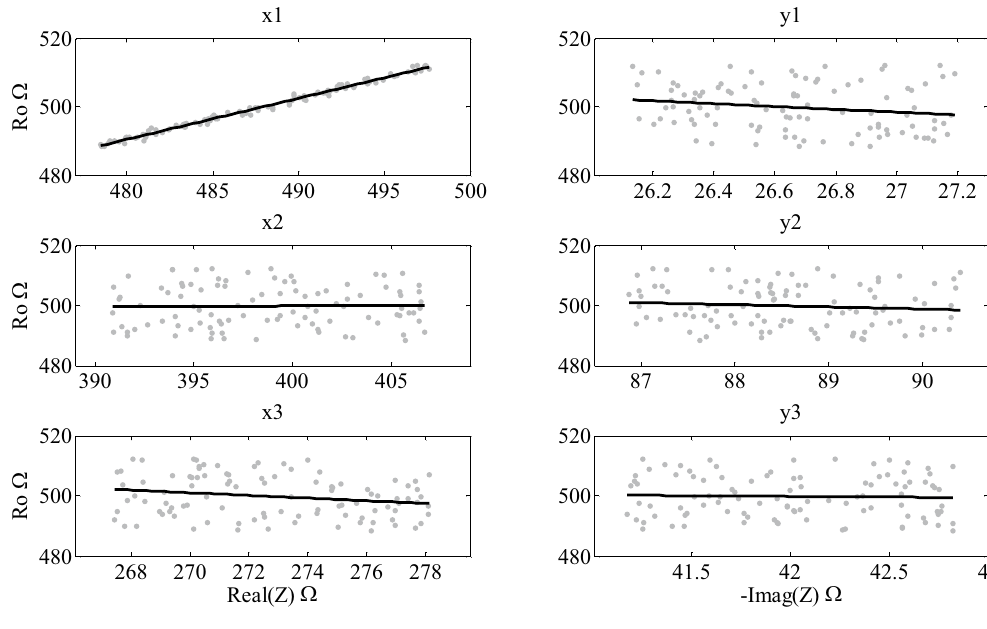
Figure 4. Scatter plots for parameter R 0 , at 2% of noise, Form 1.